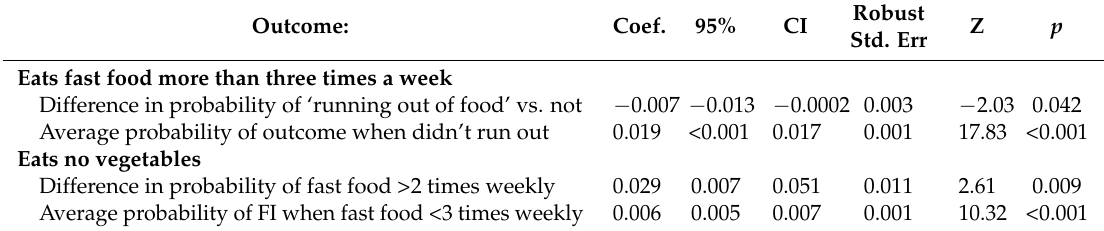
Table 4. Estimate of probability of eating fast food more than twice a week and eating no vegetables by ‘running out of food’, adjusted using propensity scores: Showing probable outcomes of ‘running out of food’, HWSS 2009-2013. Outcome: Coef. 95% CI